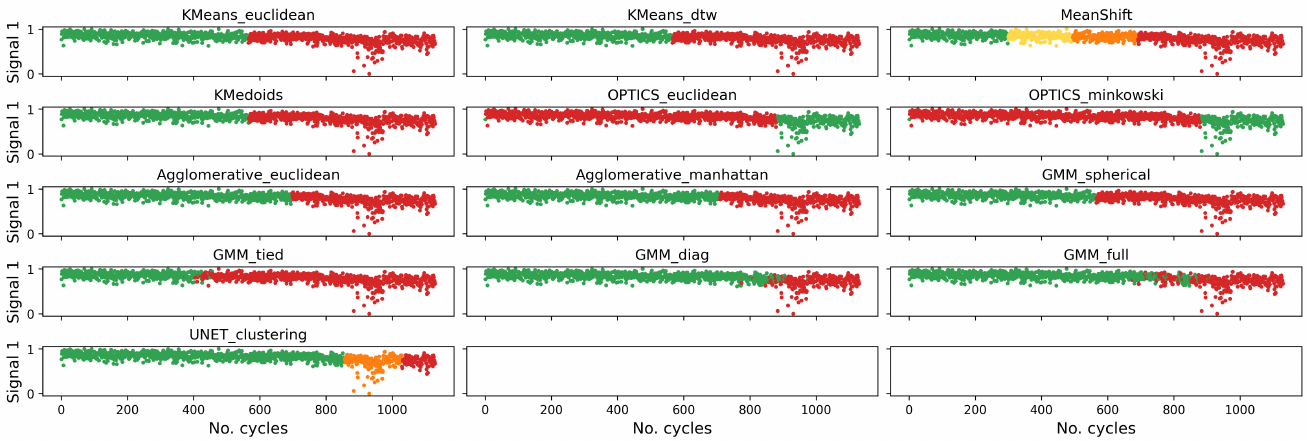
Figure 14. Clustering results with state-of-the-art algorithms for X 1